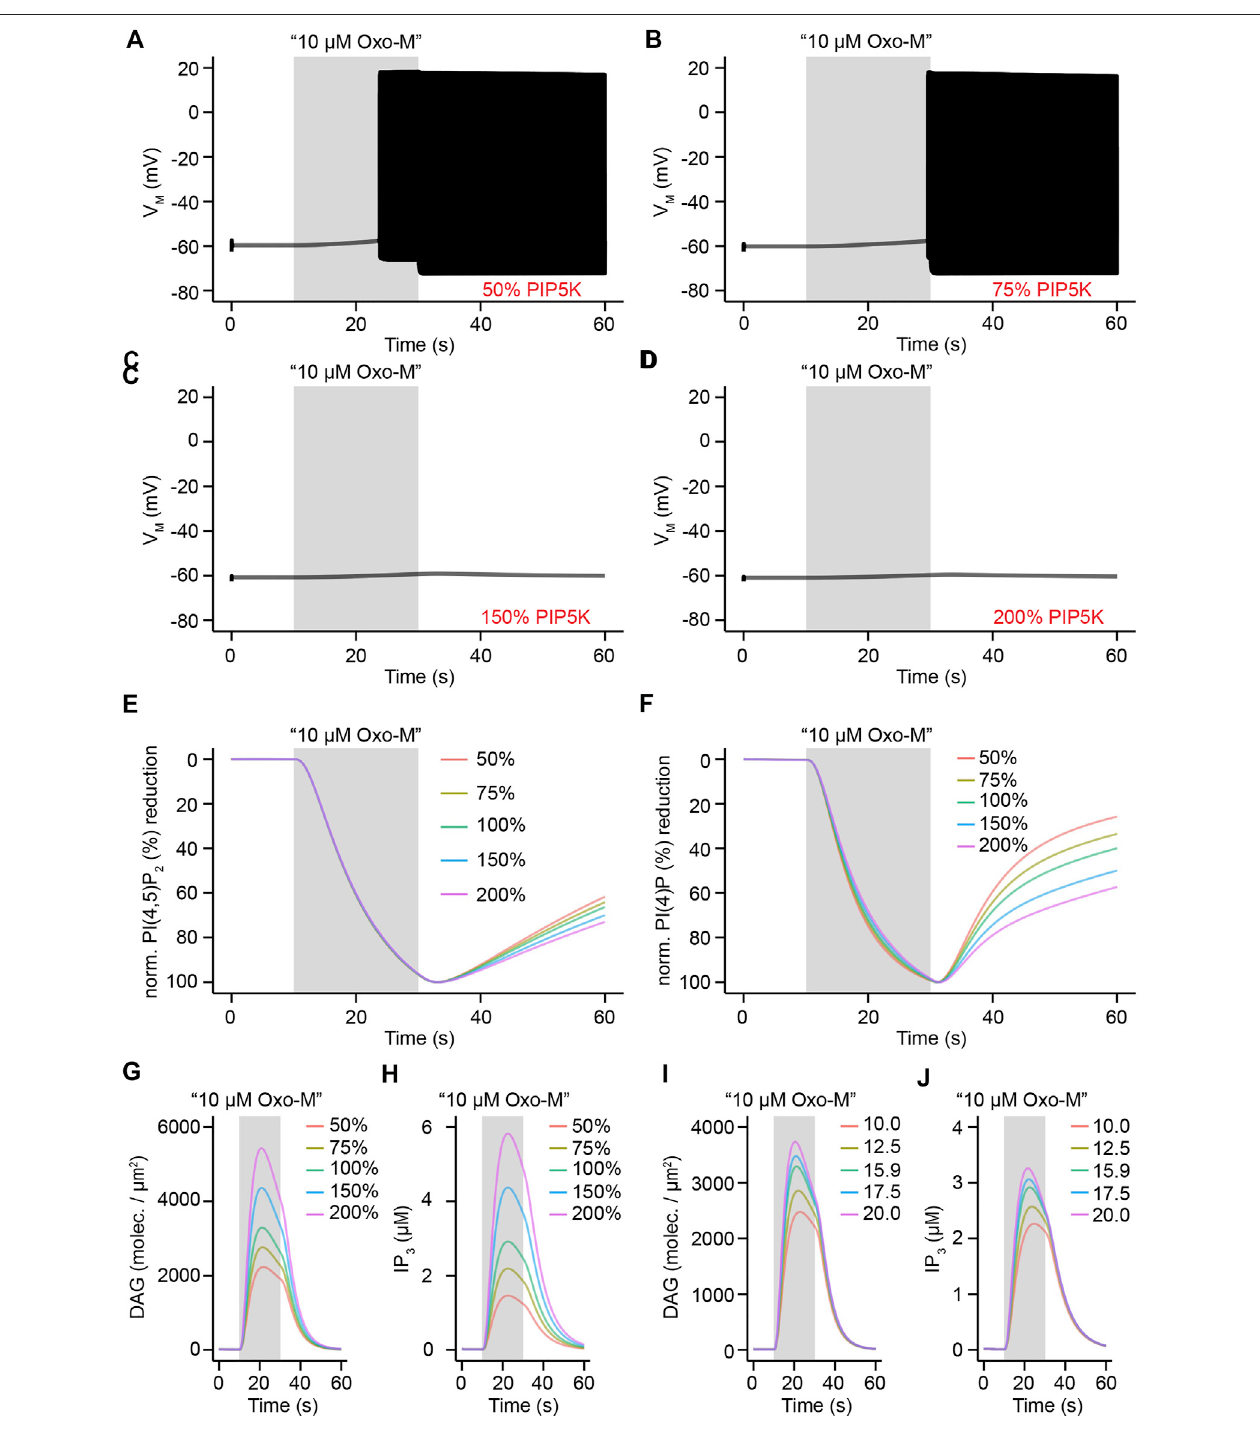
FIGURE6 | In fl uence ofPIP5K activity on electrical activity and second messenger generation inrat SCG neurons. (A) .Simulated membrane potentialin response to an application of 10 μ M Oxo-M for 20 s under conditions of reduction of PIP5K activity by 50%. (B) – (D) . Same as in A, but under conditions of 75, 150, and 200% activity of PIP5K, respectively. (E) – (H) . Normalized reductions or membrane densities and concentrations for levels of PI(4,5)P 2 (E) , PI(4)P (F) , diacylglycerol (G) , and inositol 1,4,5-trisphosphate (H) in response to an application of 10 μ M Oxo-M for 20 s with indicated levels of PIP5K activity. (I) – (J) . Same as in G and H, but for indicated levels of M 1 R surface density (molecules/ μ m 2 ) under conditions of 100% PIP5K activity.